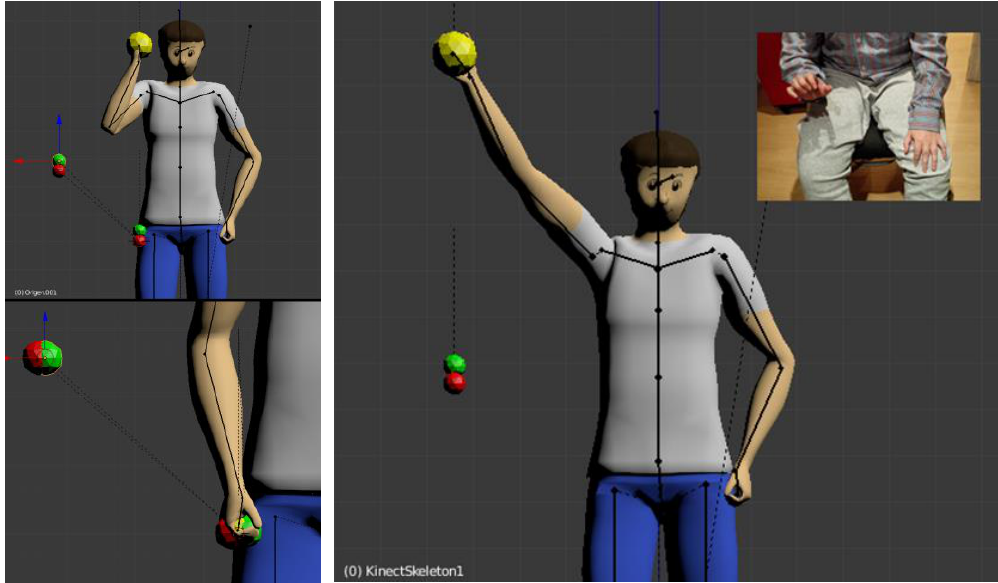
Figure 5. Amplifier with offset and avatar’s movements applying inverse kinematics. Upper left image: the user raises his hand slightly. Lower left image: the user is resting his hand on the armrest of the wheelchair. Right image: the user raises his hand as much he can (he is unable to raise the arm). As each user needs different amplification values and has a different resting position, the need The right image reveals one more problem: the resting position of the avatar’s limb. If it were simply copied from the player, in cases like the one presented here, i.e., when the player is seated and the avatar standing, the appearance would not be real, as the avatar would present an arm floating at hip level height when the player is resting. The solution is to implement an offset value that simply displaces the reference point. The result is shown in the lower left image, where the avatar’s hand is resting in the right